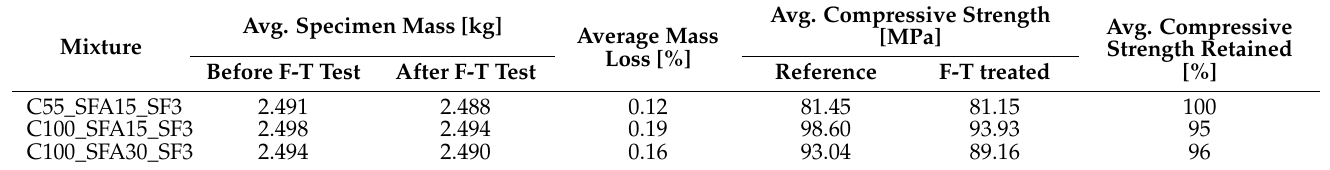
Table 8. Internal frost resistance of low-clinker HPC.